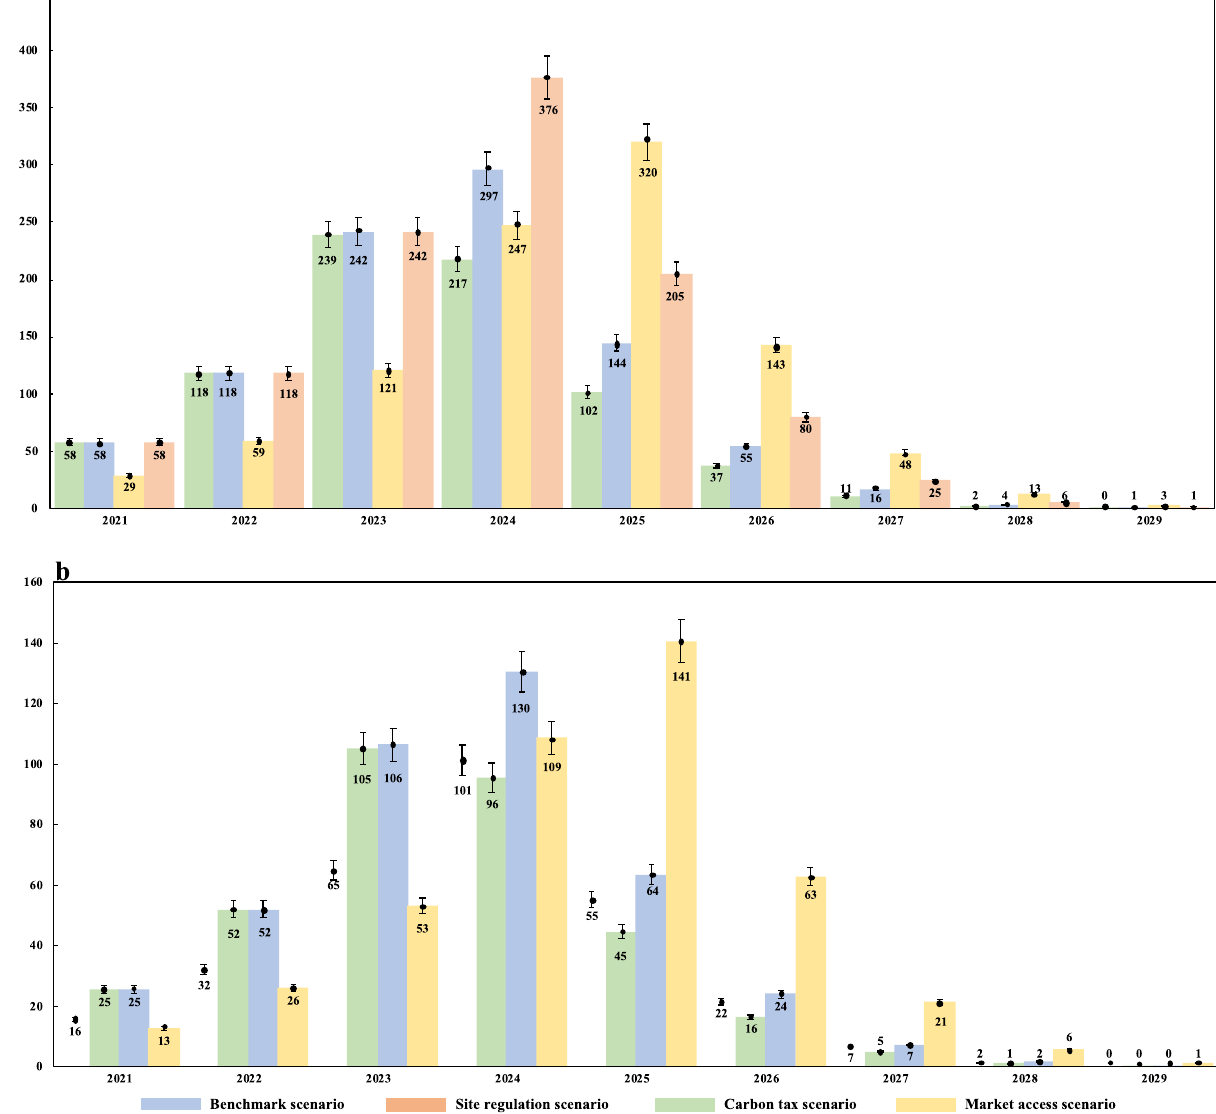
Fig. 2 Estimated annualized scenario simulation results. Estimated annualized energy consumption ( a ) and carbon emission fl ows ( b ) of Bitcoin operation in China are generated through monthly simulation results of BBCE modeling from 2021 to 2029. The blue, red, yellow, and green bars in a and b indicate the annual energy consumption and carbon emission fl ows of Chinese Bitcoin industry in benchmark, site regulation, market access, and carbon tax scenario, respectively. Each data is presented as mean values ± SEM based on 95% con fi dence intervals calculated by two-tailed t -tests ( p < 0 : 05). n = 204 emission